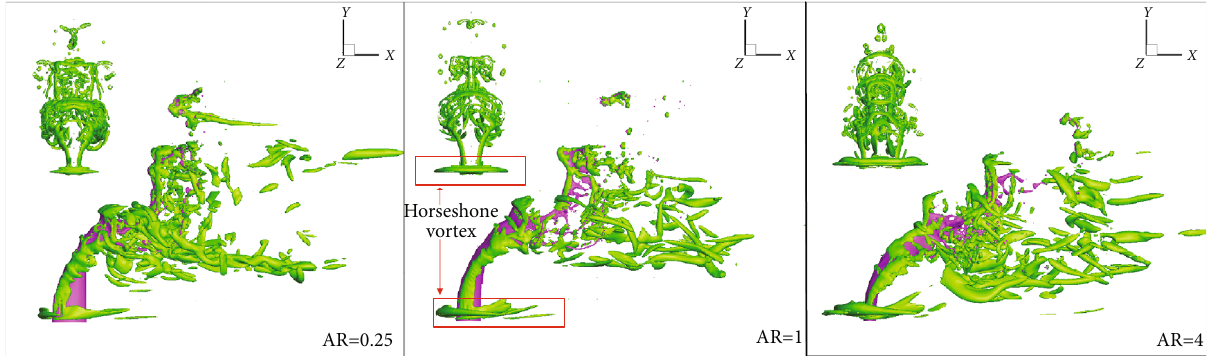
Figure 12: Instantaneous vortex structures in supersonic cross fl ow identi fi ed by isosurface of Q , t = 56 : 4 μ s.